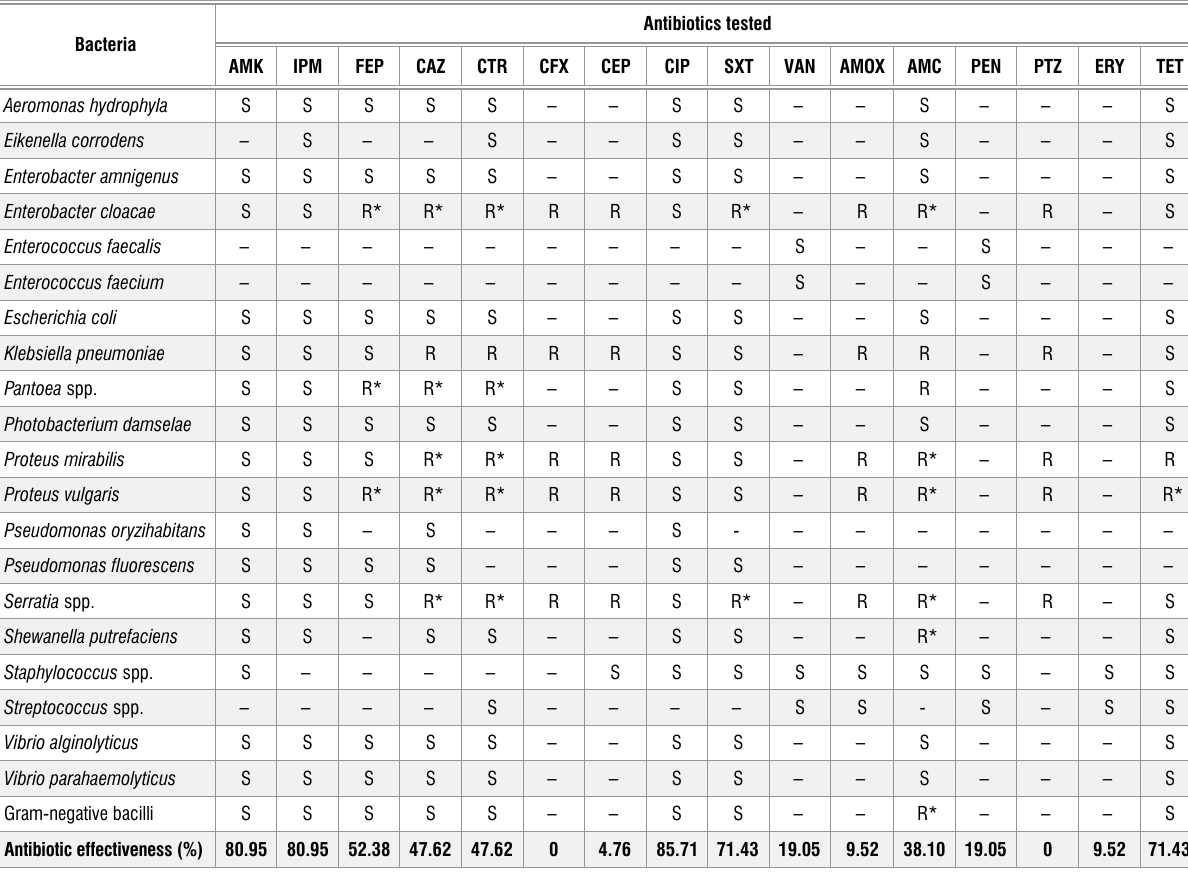
Antibiotics tested